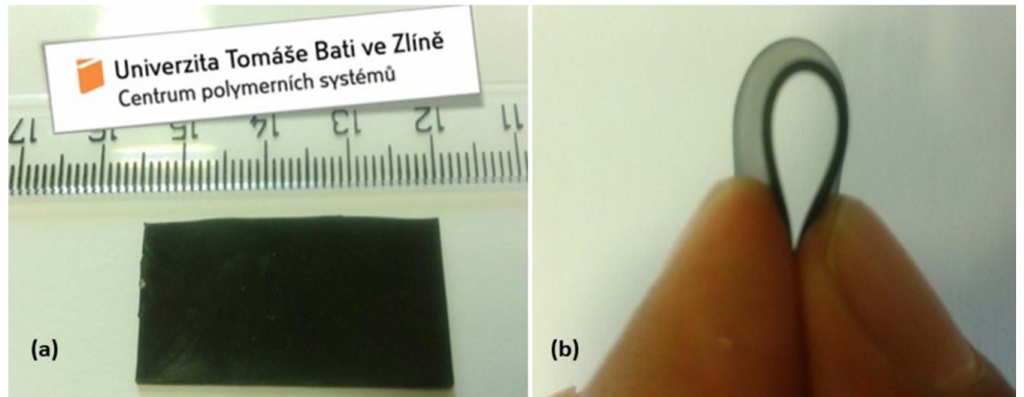
Figure 2. ( a , b ) Digital photograph of a prepared polypropylene nanocomposite with spinel ferrite NiFe 2 O 4 nanoparticles and in-situ thermally-reduced graphene